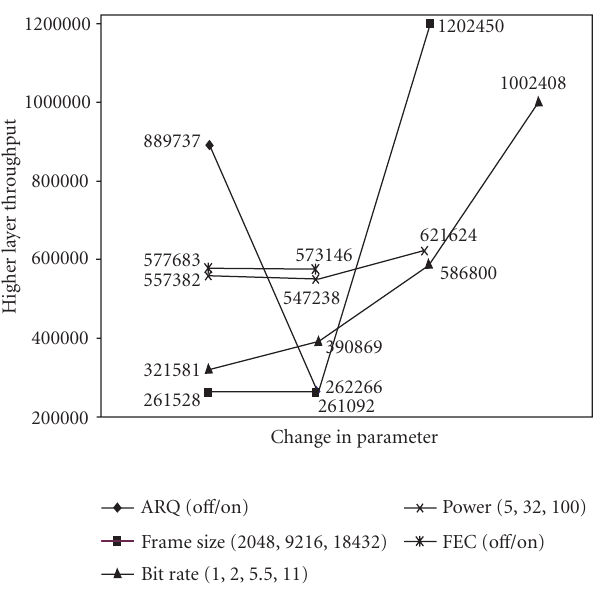
Figure 5: FTP throughput versus average e ff ect of a parameter.